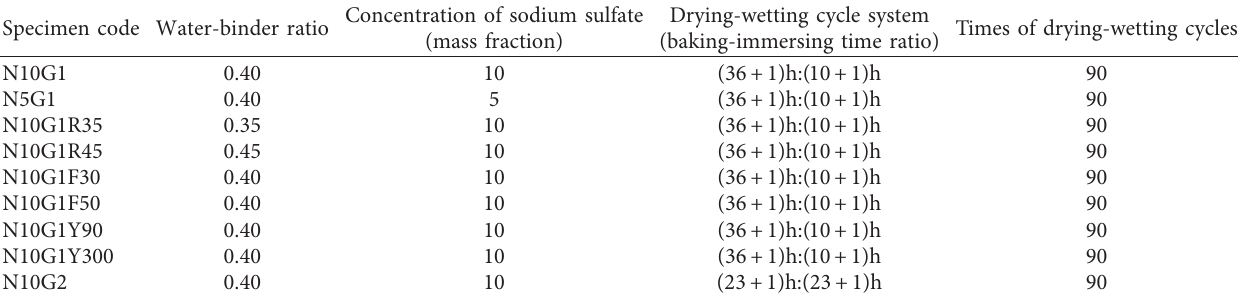
Table 3: Experimental scheme of concrete under drying-wetting cycles and sodium sulfate attack. Concentration of sodium sulfate Specimen code Water-binder ratio (mass fraction)